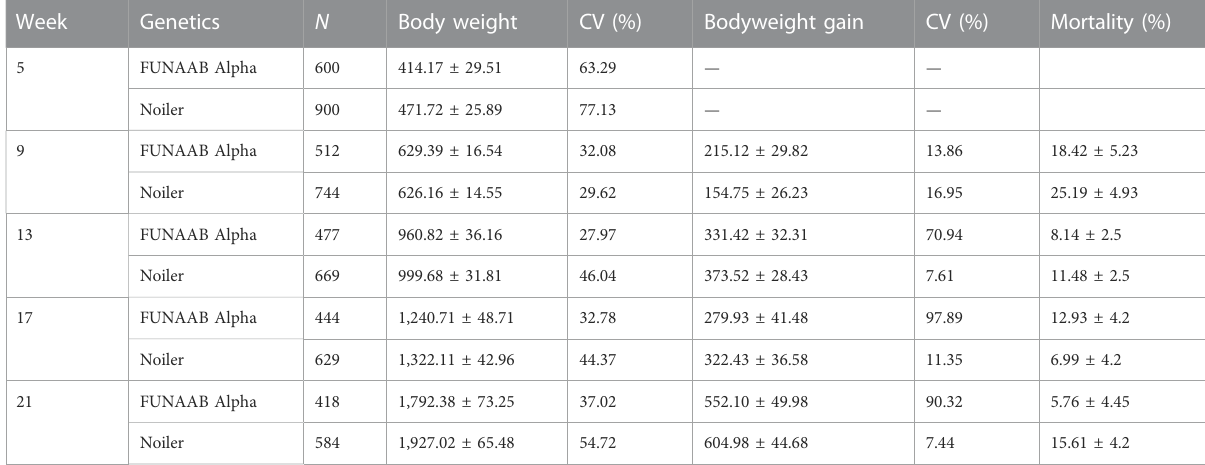
TABLE 1 Effect of genetics on body weight, weight gain, and mortality (LSM ±